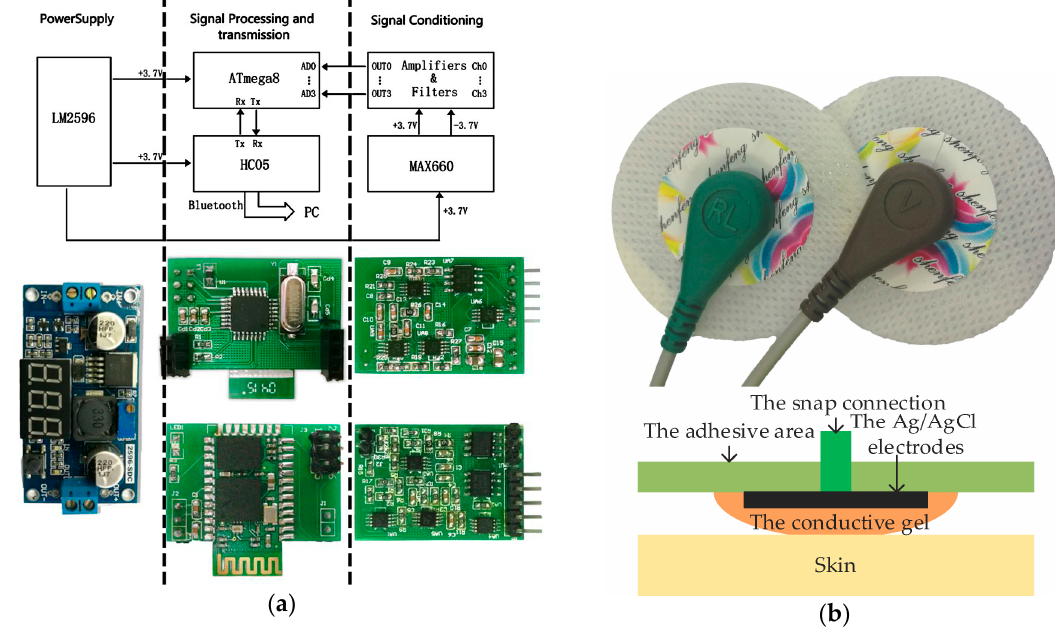
Figure 1. ( a ) The four-channel offline acquisition board; ( b ) The wet disc sensors and architecture.